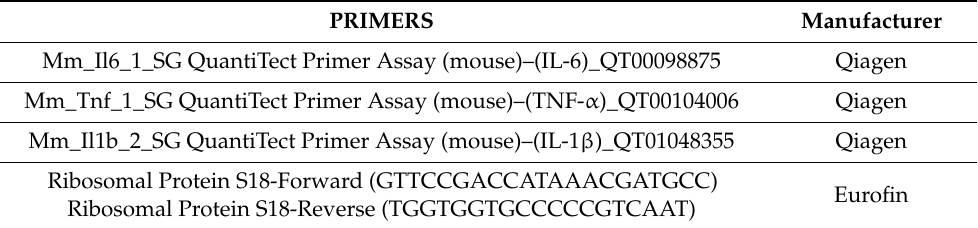
Table 1. Primers used for real-time polymerase chain reaction (PCR)